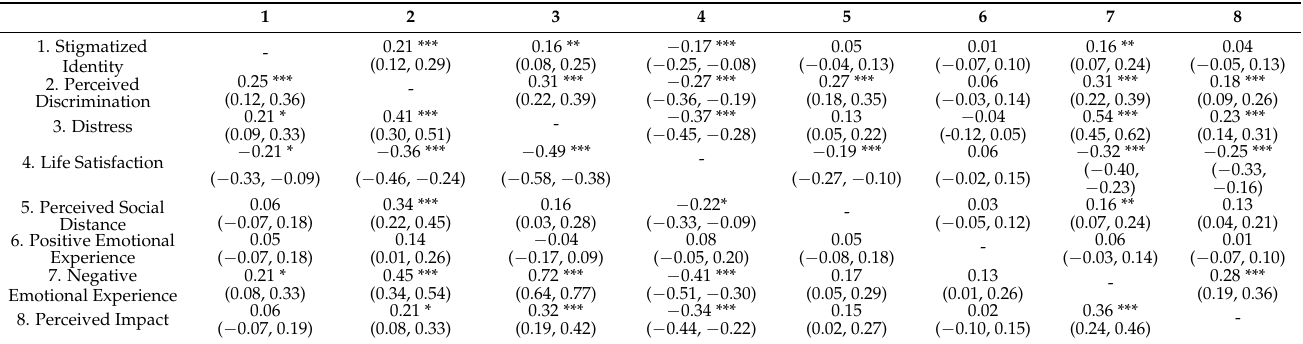
Table 3. Bivariate correlations of stigmatized identity, discrimination, and well-being